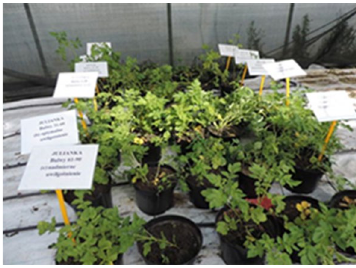
Figure 1. Establishment of pot experiment and an irrigation system with irrigation line and pot